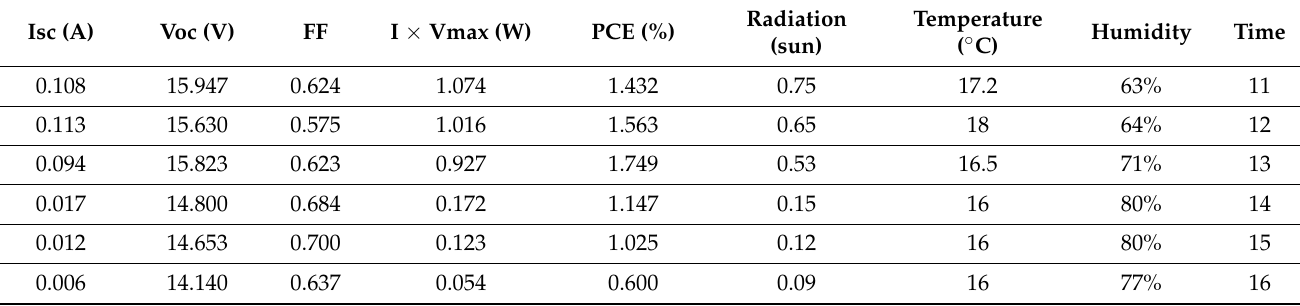
Table 1. PV characteristics of the dye-sensitized panel in the